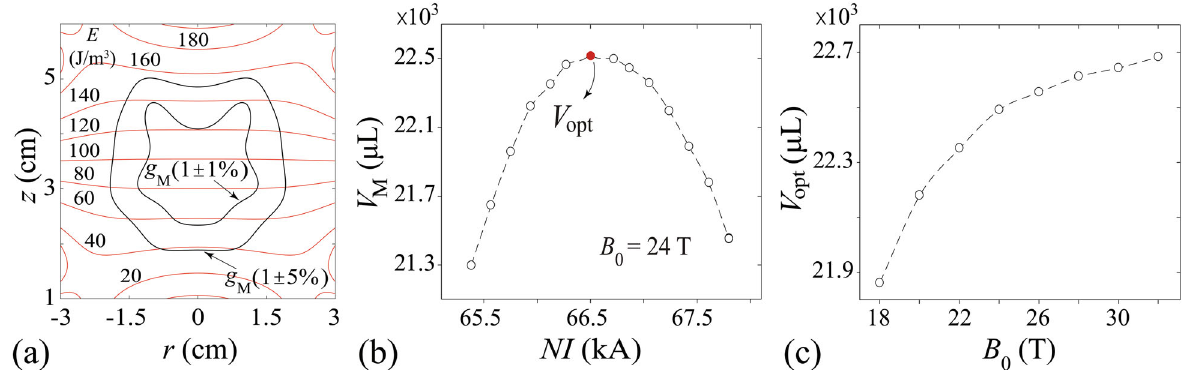
Fig. 6 Performance of the practical MLS as a Martian gravity simulator. a Contour plot of the speci fi c potential energy E ( r ) at NI = 66.55 kA and B 0 = 24 T in the practical MLS. The black contours denote the boundaries of the regions in which the total force leads to an effective gravitational acceleration within 1% and 5% of g M , respectively. b The functional volume V M in which the gravity varies within 5% of g M versus the turn-current NI . c The peak volume V opt versus B 0